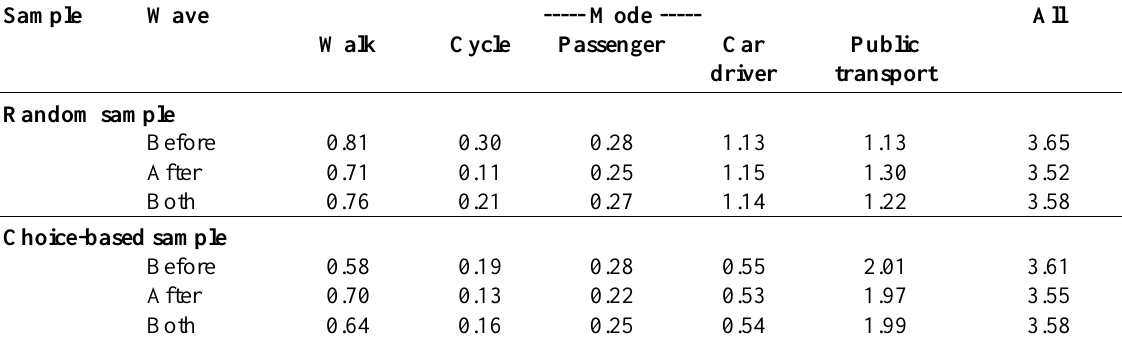
Table 4. Average number of trips by mode, sample and wave [trips/day] Sample